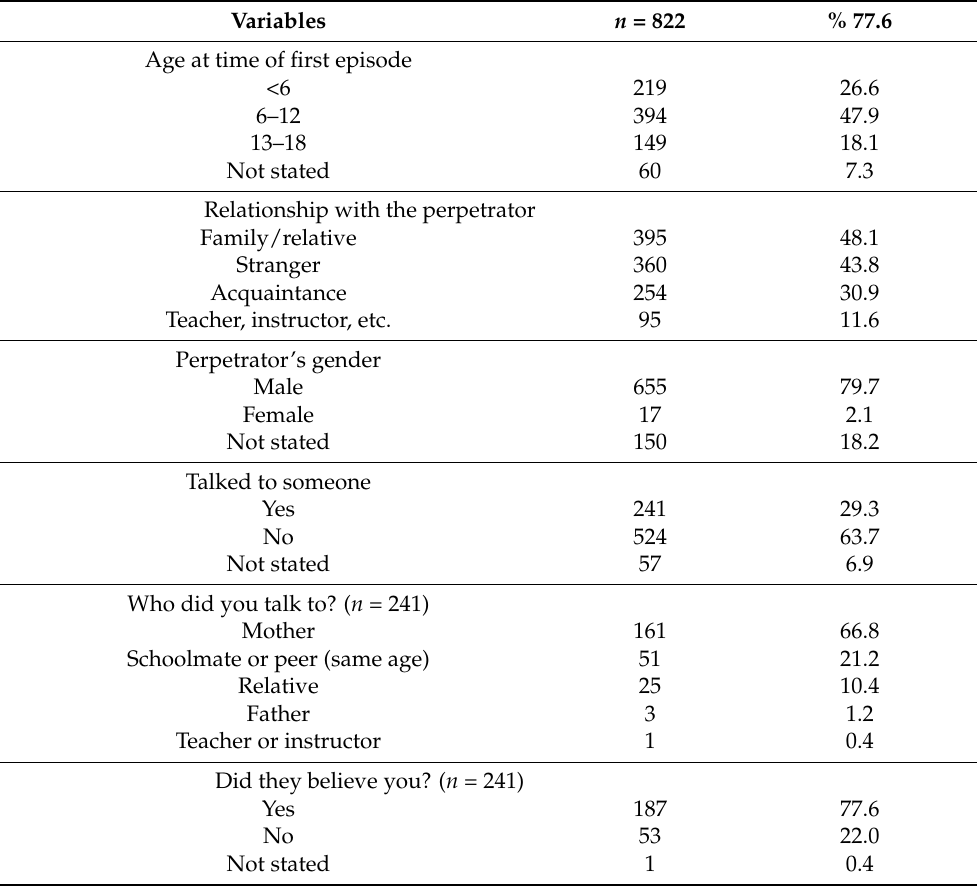
Table 2. Number of participants reporting CSA and percentages for the variables according to age, relationship to the perpetrator, who they told, and whether they were believed. Variables n = 822 % 77.6 Age at time of first episode <6